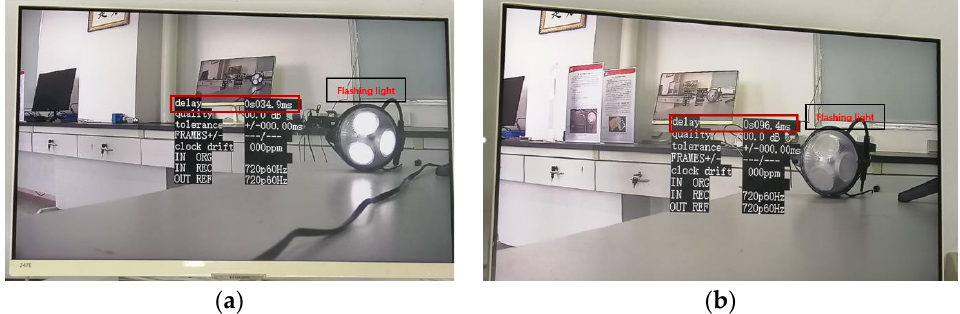
Figure 10. ( a ) Camera delay measurement result; ( b ) Method 2 Delay measurement results.